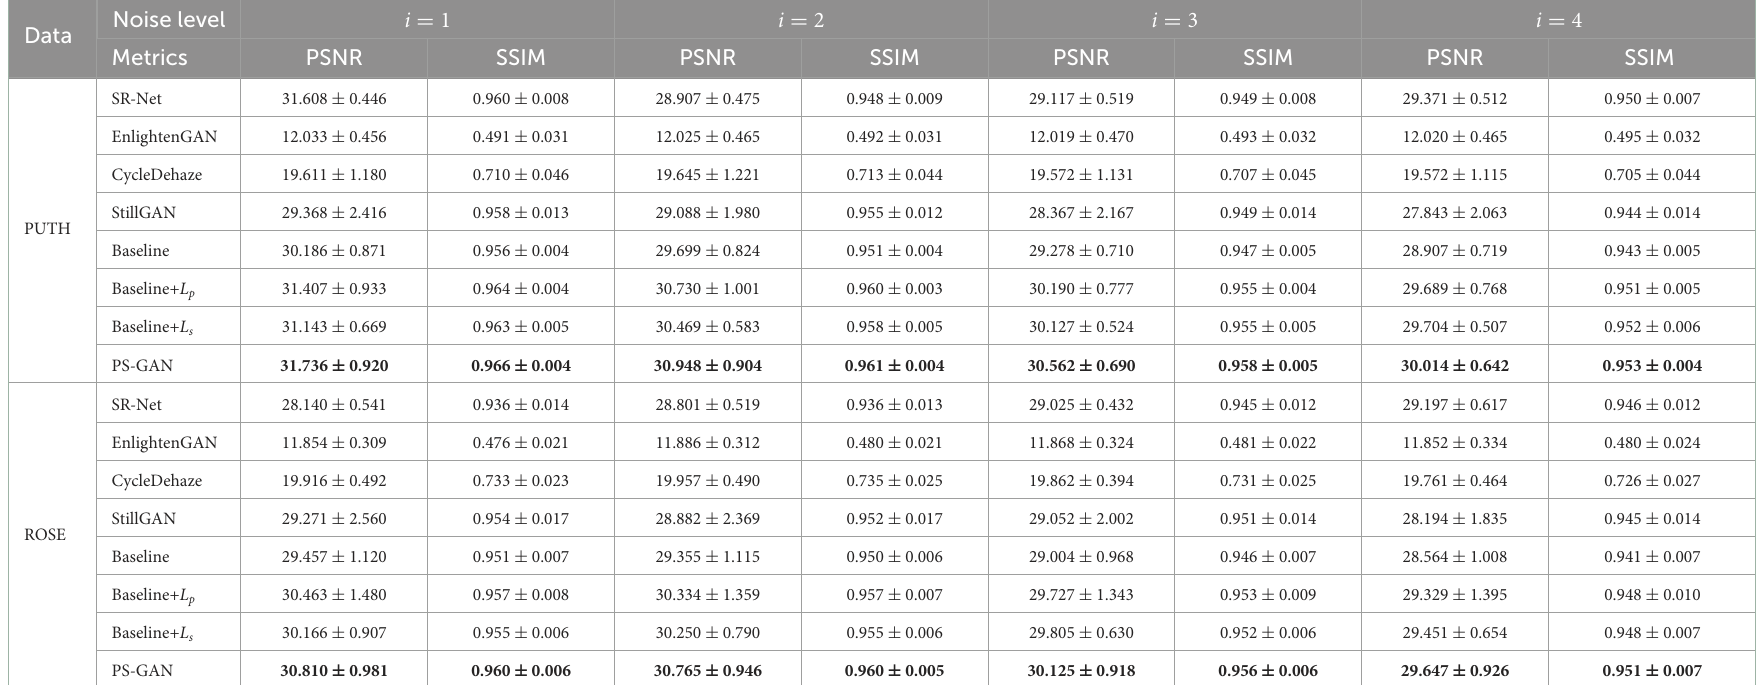
TABLE 3 Comparison of re-Enhancing performance in terms of PSNR and SSIM on the synthetic datasets.